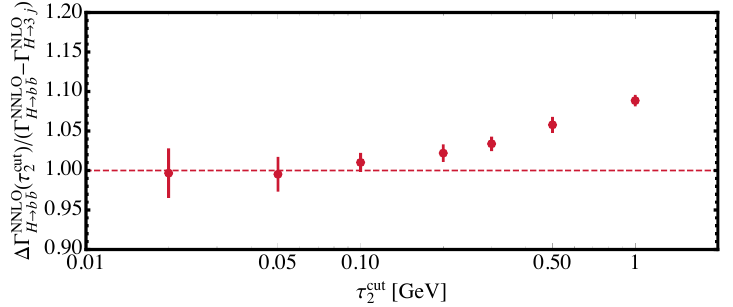
Figure 2 . The dependence of the H ! bb NNLO coe(cid:14)cient for the two-jet partial width on the N -jettiness slicing parameter (cid:28) cut . The physical jet cut is set to y cut = 0 : 1. The coe(cid:14)cient 2 is normalized to the prediction obtained from the di(cid:11)erence of the inclusive result and the NLO (inclusive) three-jet